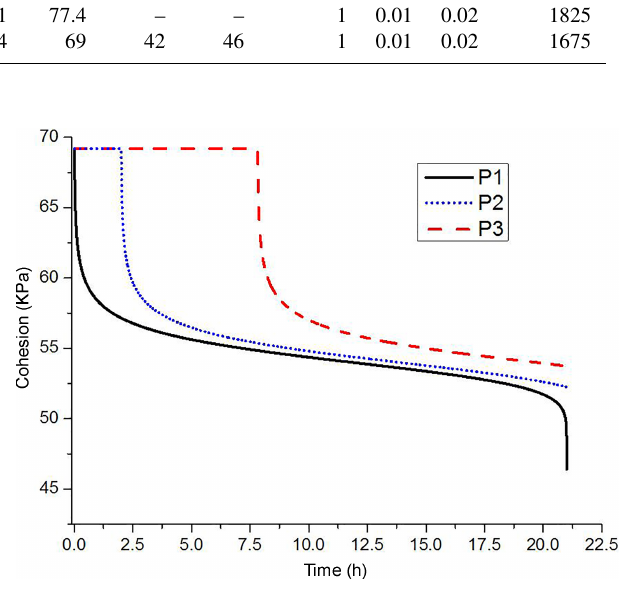
Figure 12. Evolution of apparent cohesion at points P1, P2, and P3.